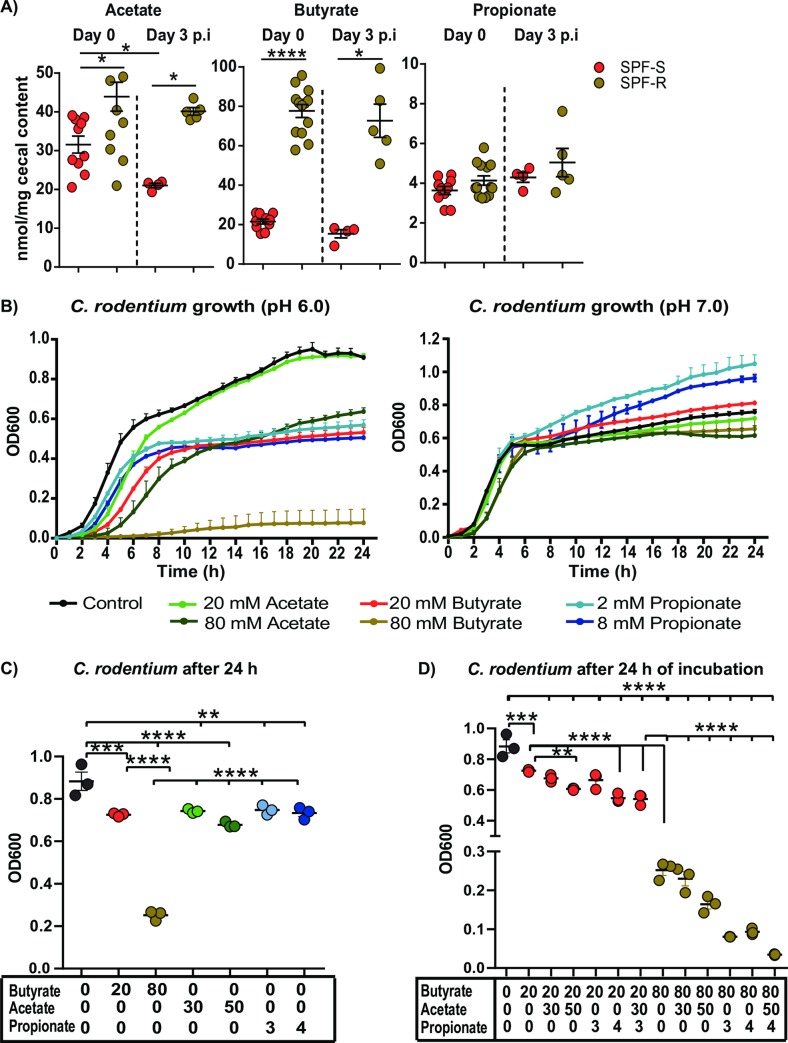
The metabolome of resistant SPF-R is characterized by elevated SCFA levels, which strongly impair the growth of C. rodentium in vitro at pH 6.0.(A) Cecal SCFA levels of butyrate, acetate and propionate for SPF-S and SPF-R mice at steady state and day 3 p.i. are displayed in nmol/mg cecal content. Pooled results of two independent experiments as mean ± SEM are shown. P values indicated represent a Mann-Whitney U test comparison between groups with *p<0.05, ****p<0.0001. (B) C. rodentium growth displayed as optical density (OD) over time at pH 6.0 (left) or pH (7.0) in BHI medium supplemented with different concentrations of acetate, butyrate or propionate or without any SCFA added. (C-D) Citrobacter growth displayed as optical density (OD) over time at pH 6.0 in BHI medium supplemented with different mixtures of acetate, butyrate and propionate or without any SCFA added. (C-D) One data point represents mean value of three replicates. Values out of three independent experiments are displayed. P values indicated represent a One-way ANOVA between groups with **p<0.01, ***p<0.001, ****p<0.0001.